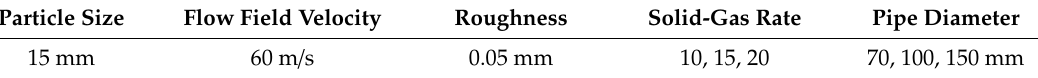
Table 2. Simulation parameters.